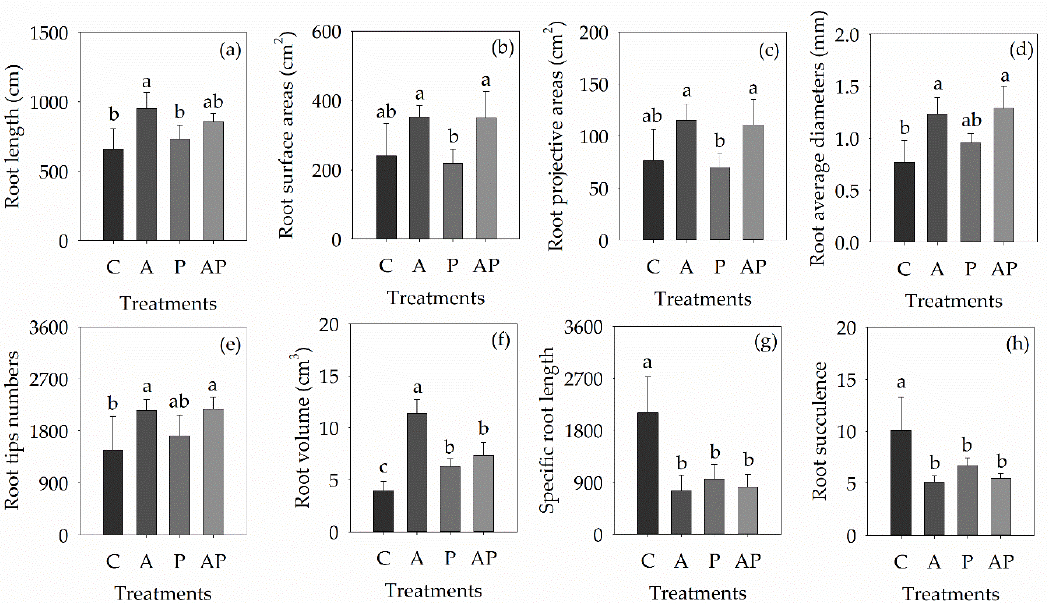
Figure 5. Effects of Glomus mosseae and Bacillus amyloliquefaciens on root morphological characteristics of Elaeagnus angustifolia L. seedlings in saline soils. Values are the means ± standard deviation of five replicates. Value sharing the different letters indicate significant differences between treatments at the 5% level (Tukey’s t -test). C: Control, A: AMF ( Glomus mosseae ) treatment, P: PGPR ( Bacillus amyloliquefaciens ) treatment, AP: AMF + PGPR treatment. ( a ) root length, ( b ) root surface areas, ( c ) root projective areas, ( d ) root average diameters, ( e ) root tips numbers, ( f ) root volume, ( g ) specific root length, ( h ) root succulence.